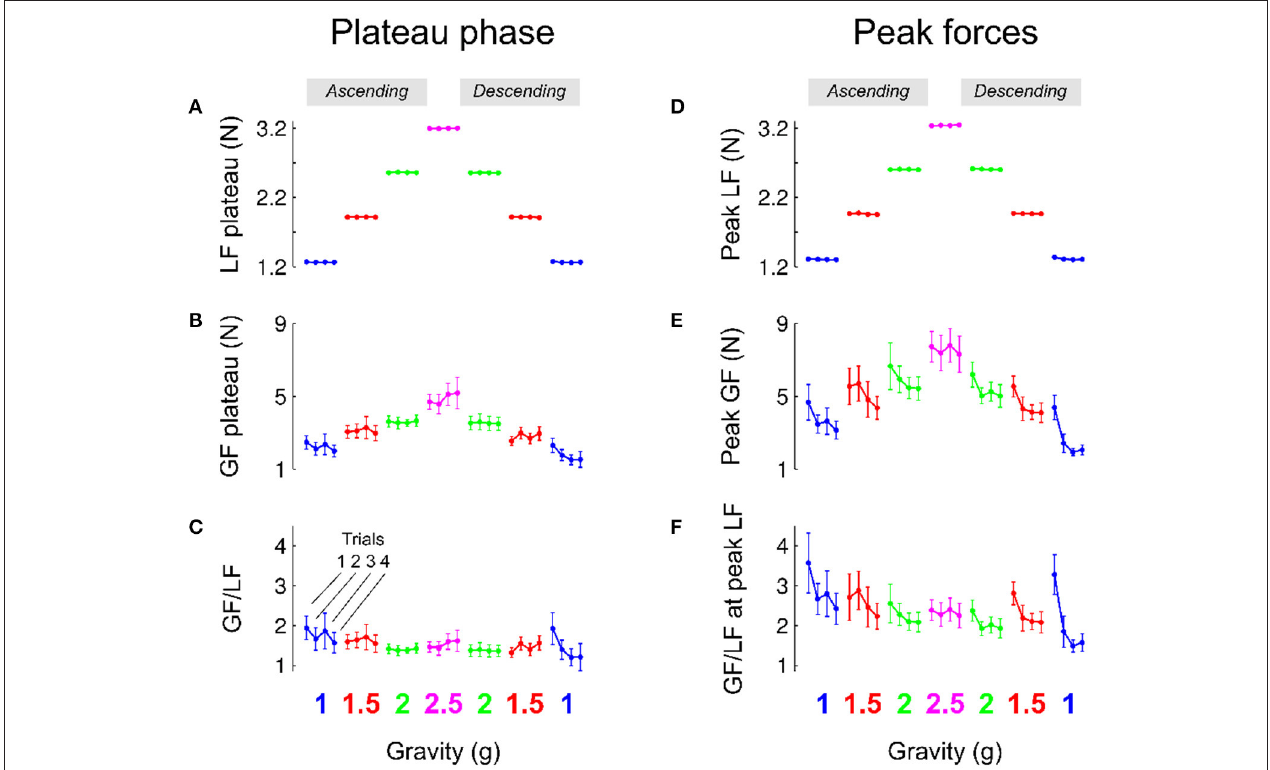
FIGURE 3 | Mean and SEM of parameters of the task that characterize the plateau phase (left column, A–C ) and when load force reached a maximum (right column, D–F ). Data are presented in chronological order, following the successive exposures to 1, 1.5, 2, 2.5, 2, 1.5g and back to 1g (same color code as in Figure 1 ). Data are also shown separately for each trial in a given environment ( C , 1g). The “ascending” (resp. “descending”) phase comprised the increasing (resp. decreasing) gravitoinertial environments 1–2.5g (resp. 2.5–1g).